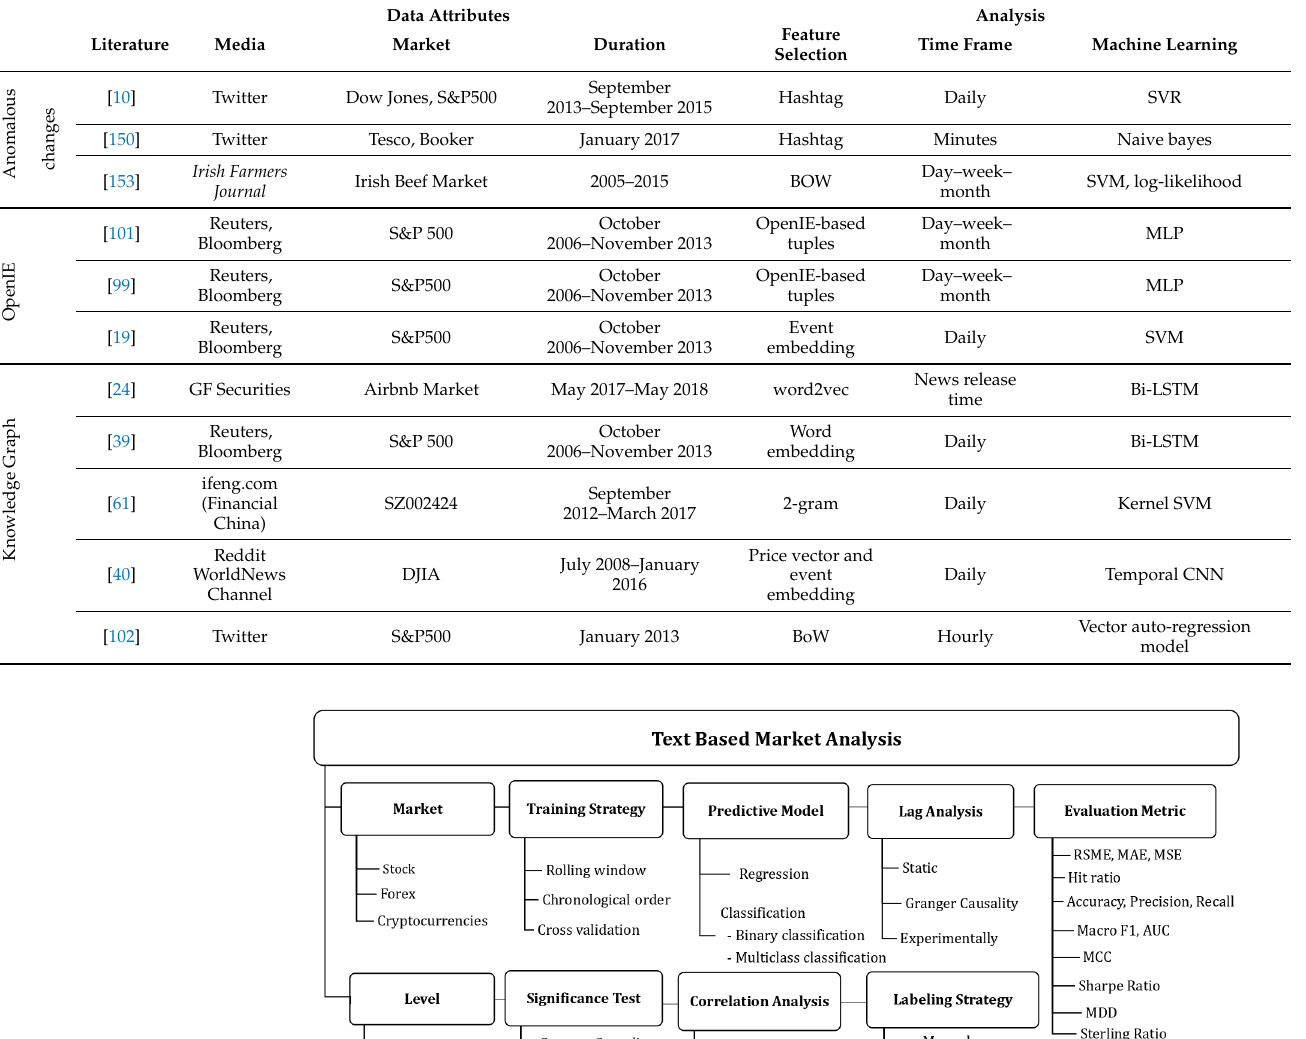
Table 4. Comparison of event detection methods.